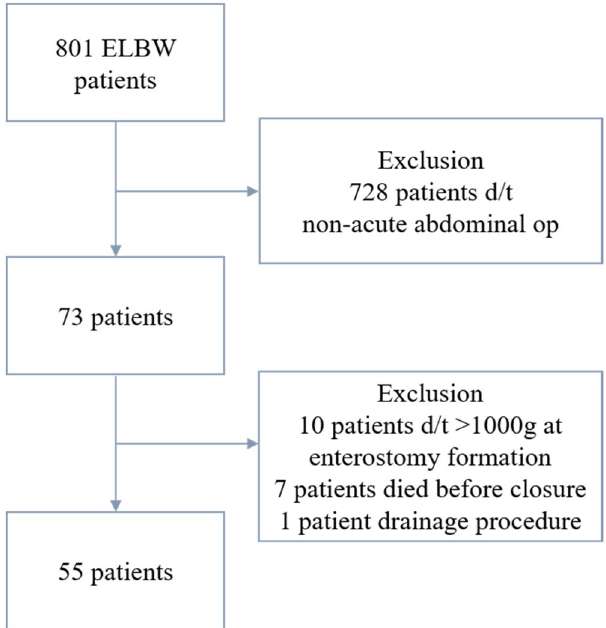
Figure 2. Flow chart of patient inclusion process.